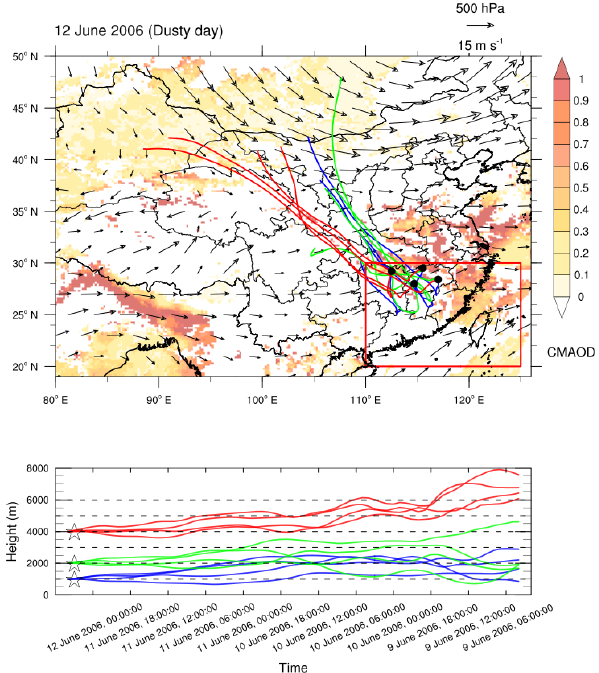
Figure 2. The horizontal distribution of coarse-mode aerosol opti- cal depth derived from Terra MODIS, wind fields at 500hPa, and 72h back trajectories from the HYSPLIT model on 12 June 2006. The red box indicates the study area, and the geolocations of the four starting points are at 29.5 ◦ N, 115.5 ◦ E; 28 ◦ N, 114.7 ◦ E; 28.4 ◦ N, 117 ◦ E; and 29.2 ◦ N, 112.5 ◦ E, with altitudes of 1000m (blue line), 2000m (green line), and 4000m (red line), extrapolated from 12 June 2006 at